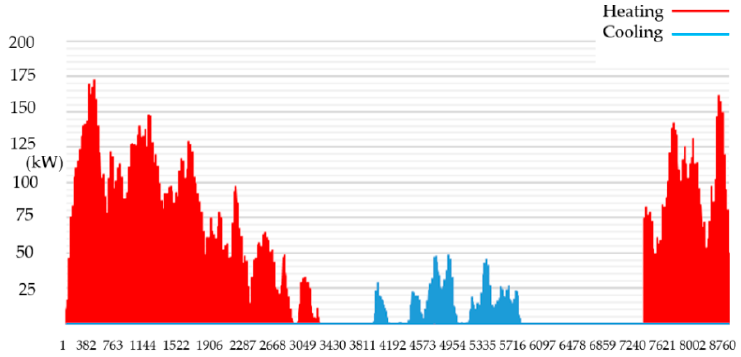
Figure 3. Yearly trend of the building load.